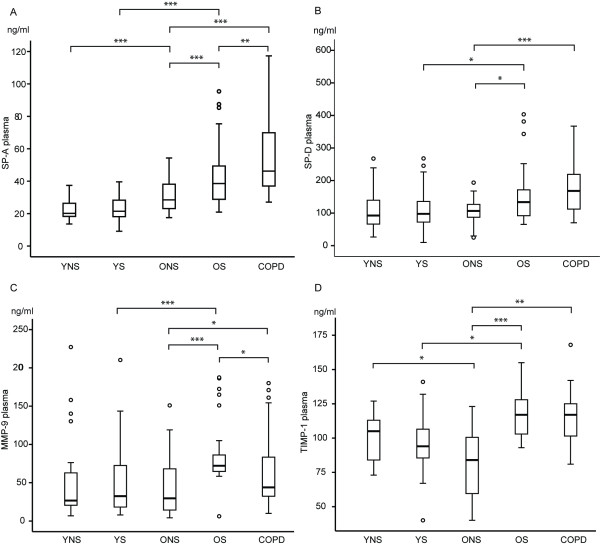
Box-and-whisker plots of SP-A, SP-D, MMP-9 and TIMP-1 in plasma (A, B, C and D, respectively). The boxes represent the 25th to 75th percentiles, the solid lines within the boxes show the median values, the whiskers are the 10th and 90th percentiles, and the points represent outliers. *: p < 0.05; **: p < 0.01; ***: p < 0.001 (between two groups, t-test).